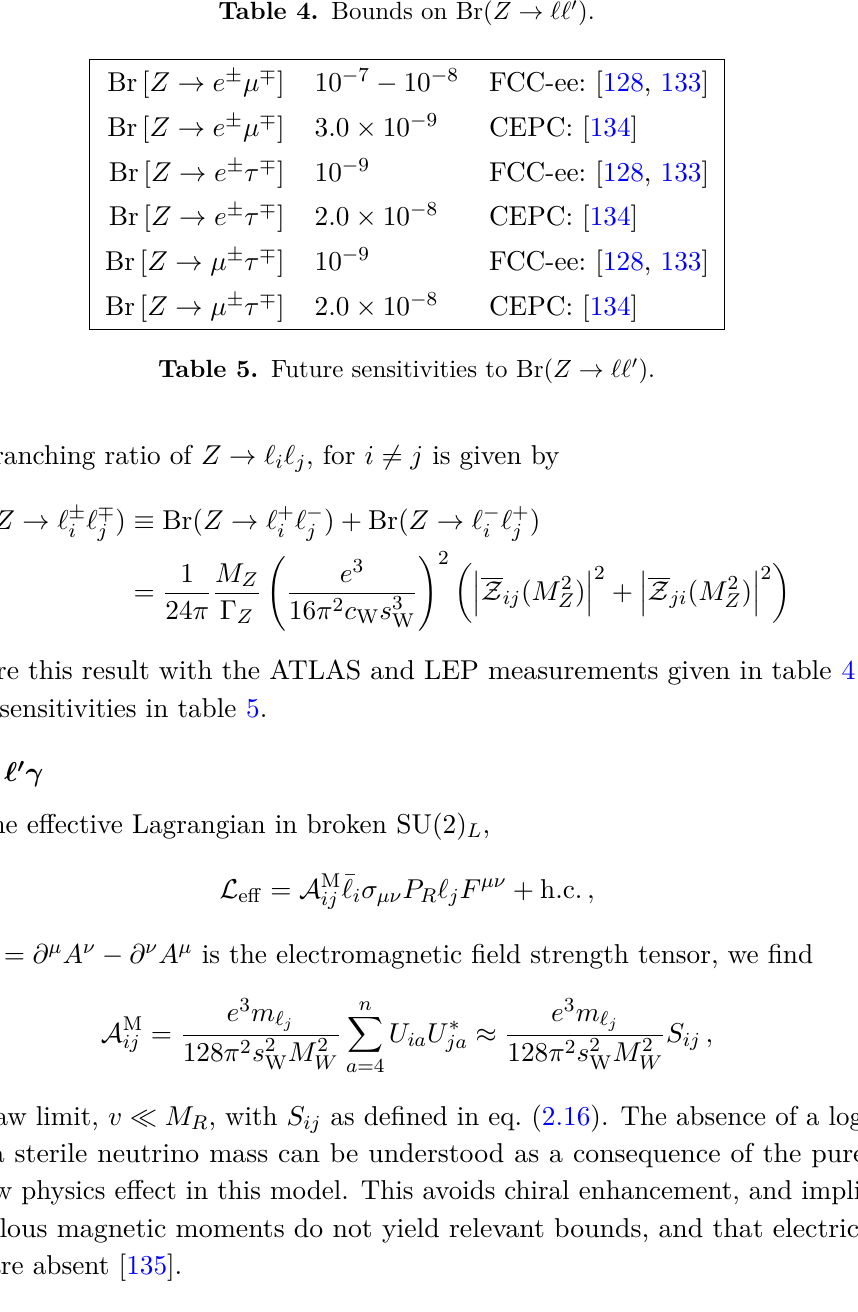
Table 4. Bounds on Br( Z → ‘‘ 0 ) .